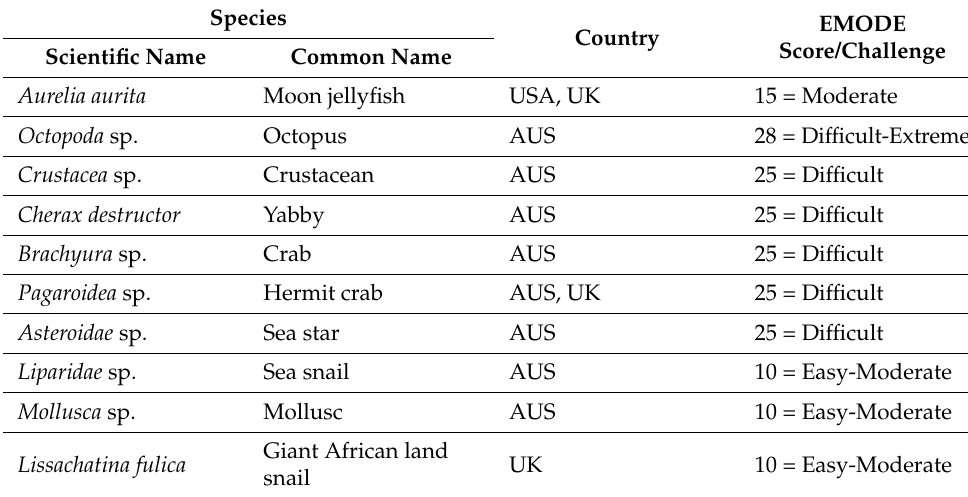
Table 3. Invertebrates involved in handling and other practices at mobile zoos by species and country of where used, and their EMODE* ‘suitability to keep’